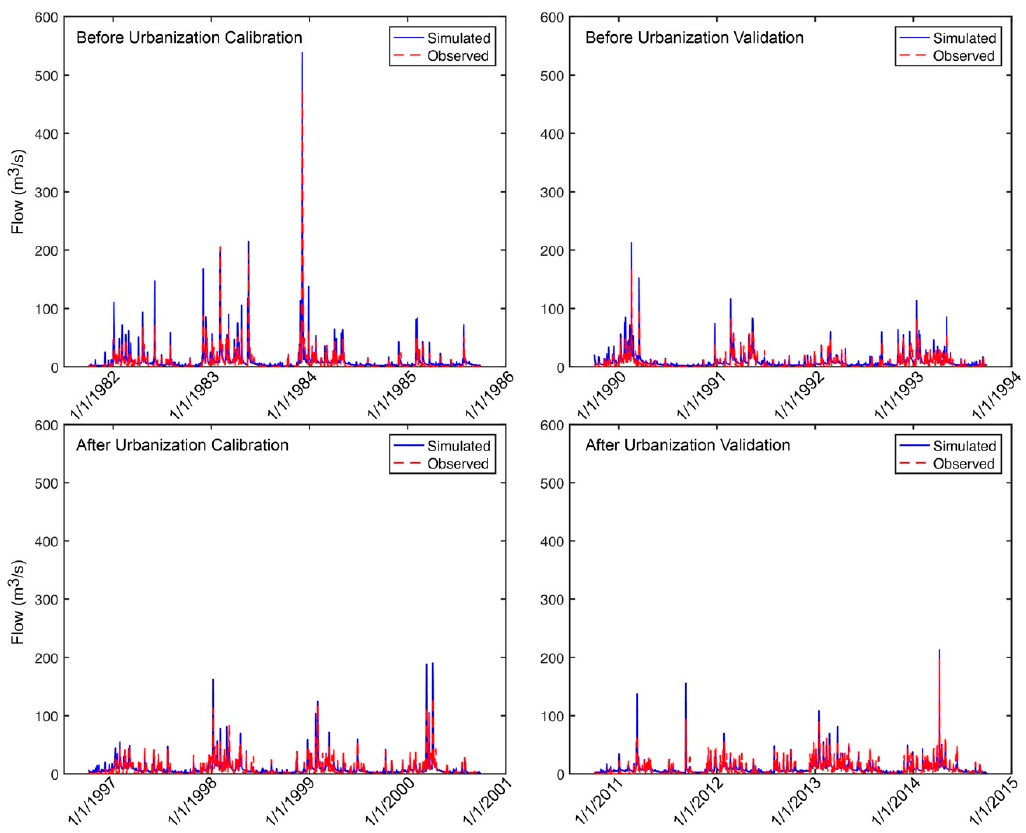
Figure A1. Hydrograph comparison of observed flows and flows simulated by HEC-HMS over the calibration and validation periods for the before-urbanization model and the after-urbanization model. Table A4. Slope, p -value, and R 2 value for IHA single period trend analysis for watersheds U1 and C1. Positive slope values indicate an increase in the parameter.